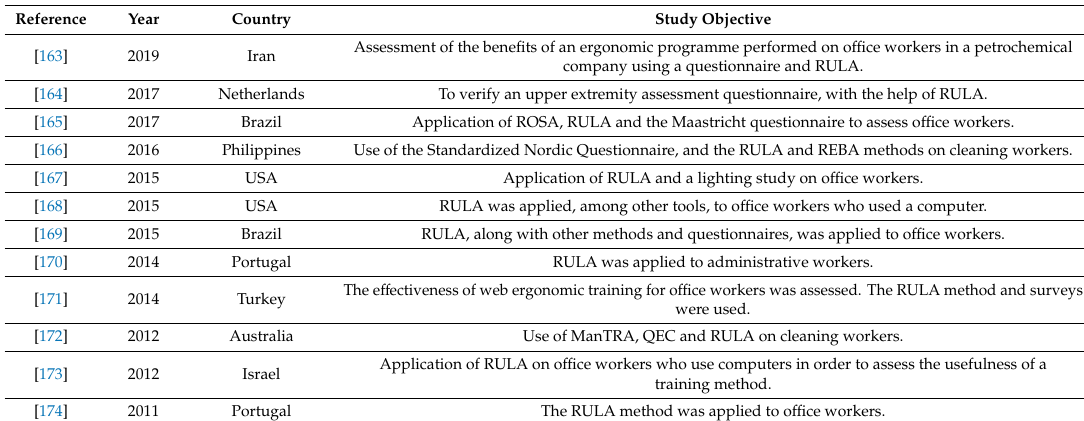
Table 14. Administrative and support service